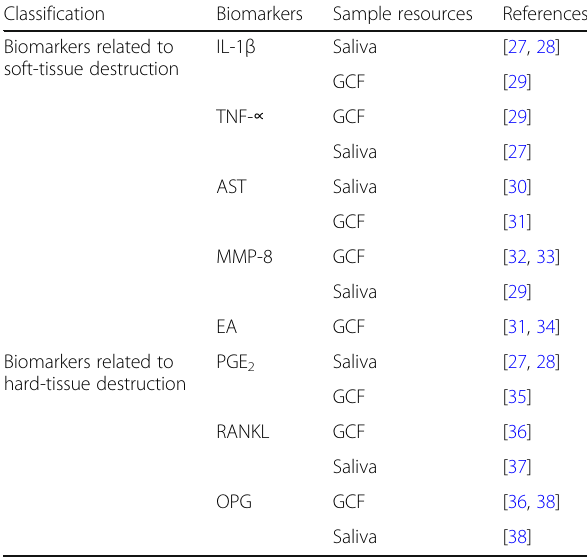
Table 1 Tissue destructive biomarkers in periodontitis